Question: Identify the chart type used in this figure.
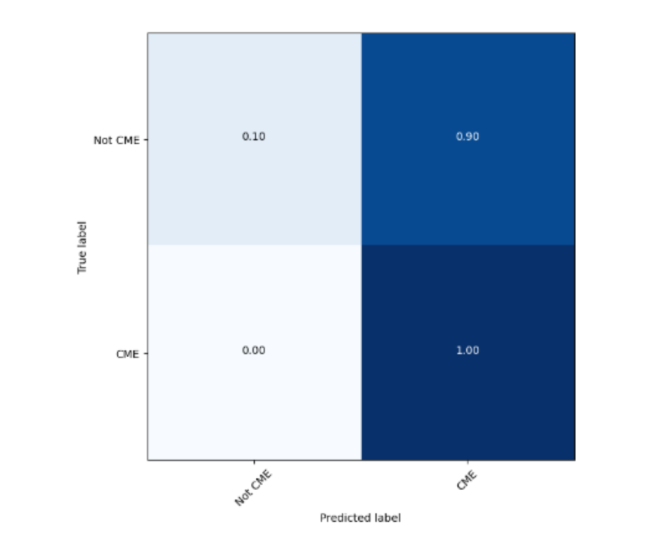
Answer: heatmap